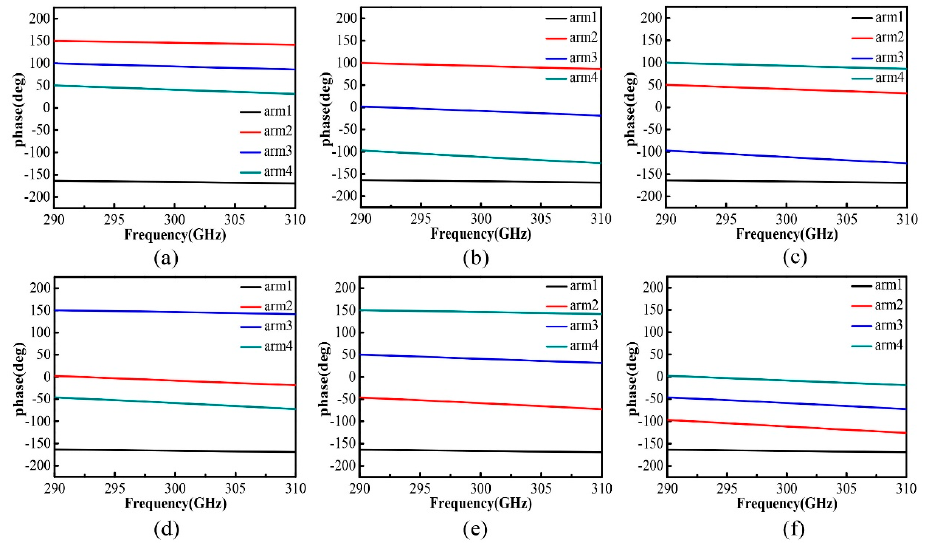
Figure 3. Phase of radiation patch obtained from each arm of feeding line in ( a ) element 2 ( b ) element 3 ( c ) element 4 ( d ) element 5 ( e ) element 6 ( f ) element 7.